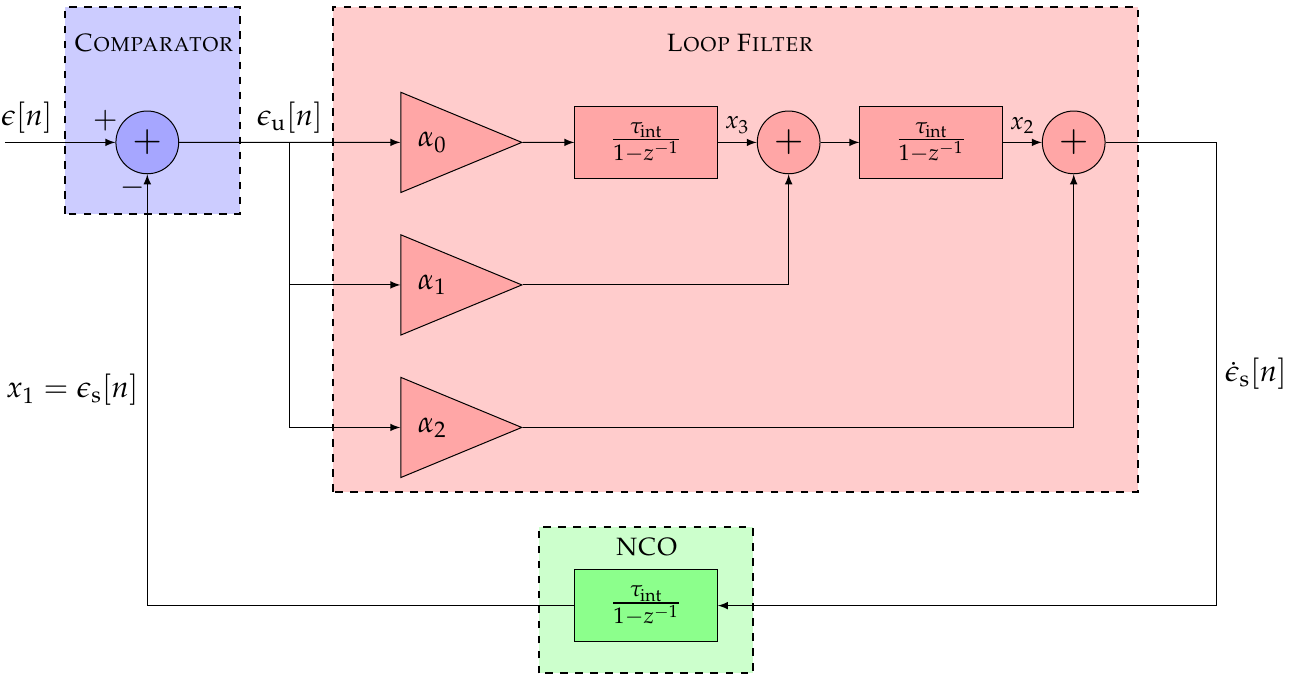
Figure 4. Linear model of a third-order